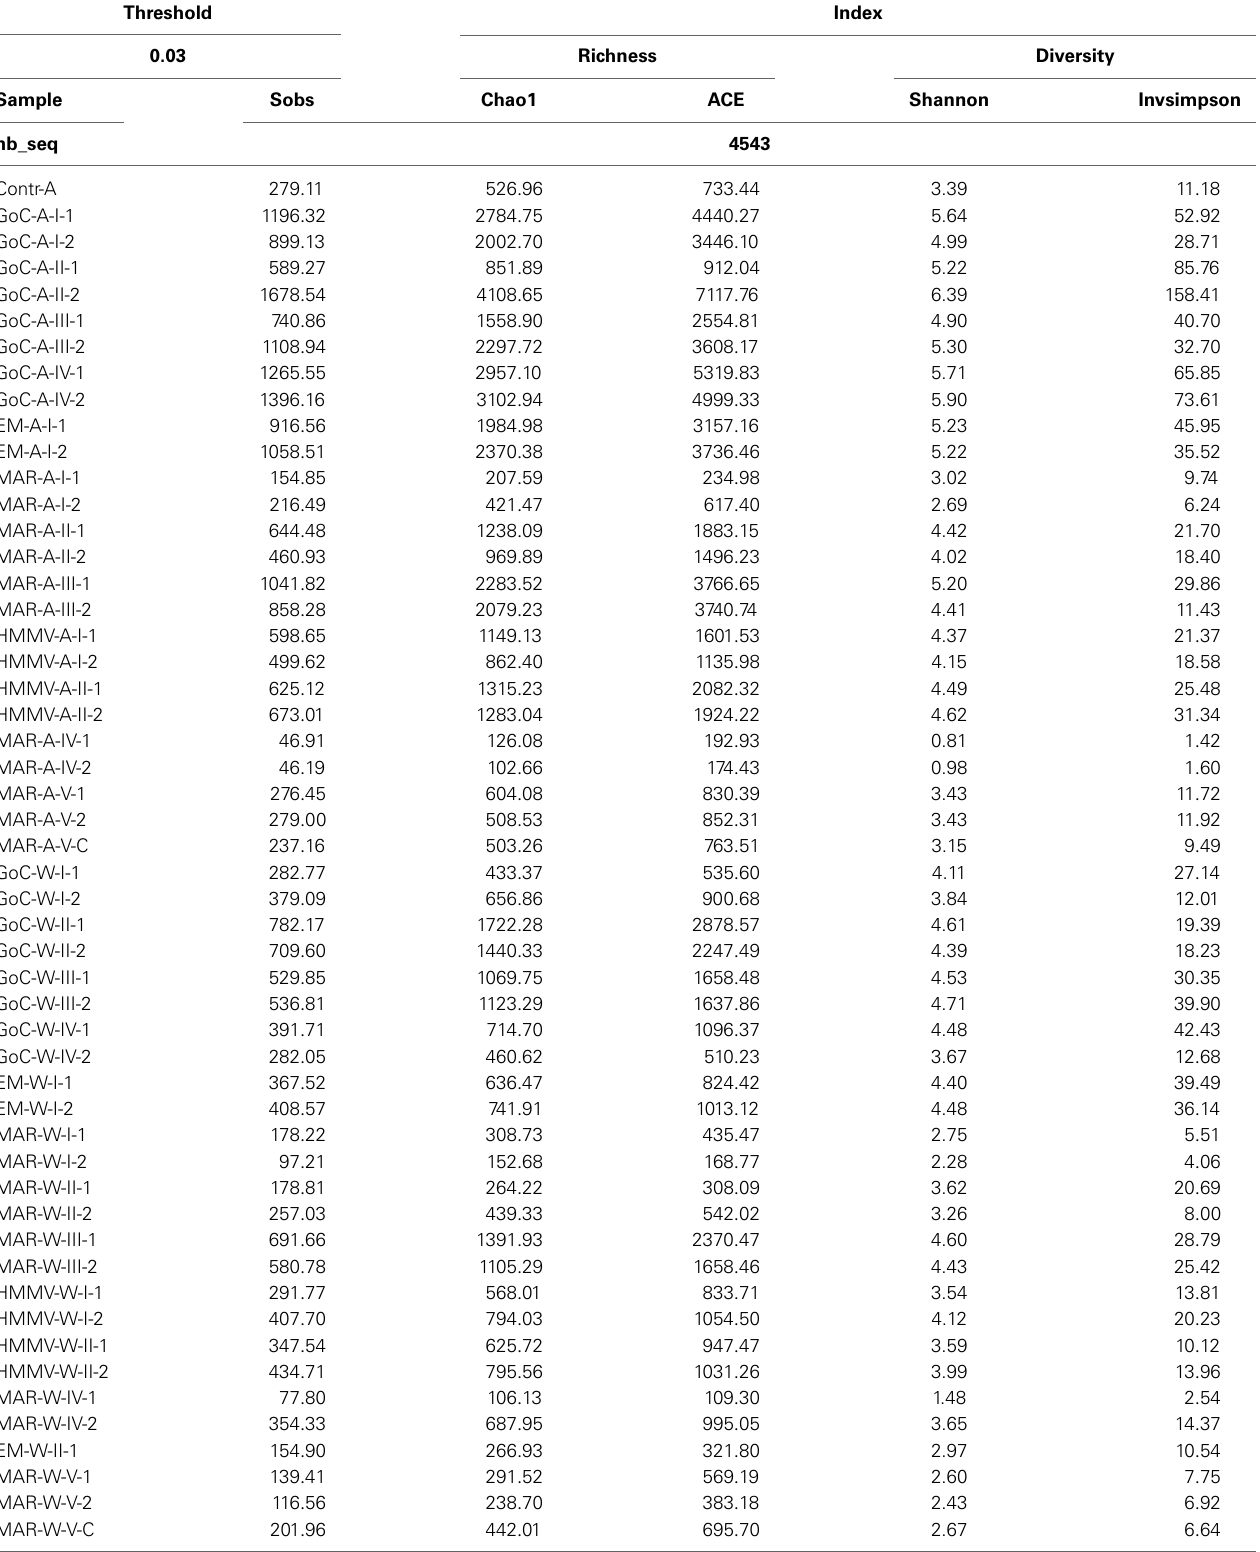
Table 2 | Species richness and diversity indices calculated for each sample in Mothur (Schloss et al., 2009) for sequences with OTU identity threshold at